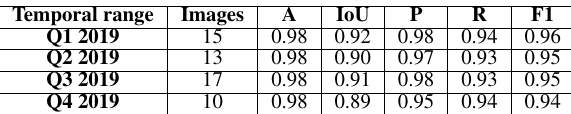
Table 2. Metrics of the AWEI approach with a time range of three months (Sentinel-2).